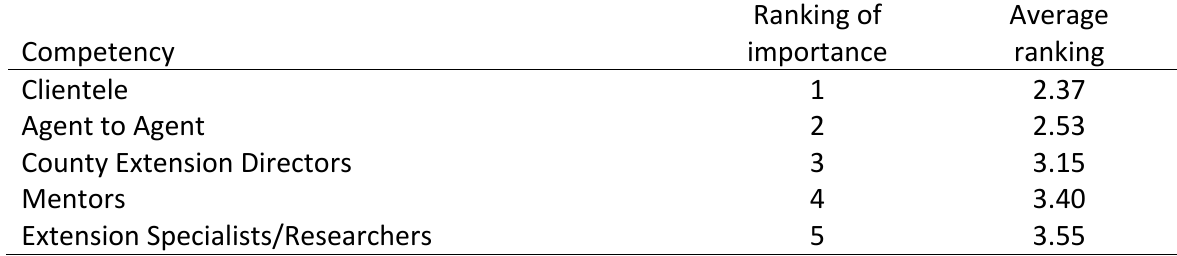
Ranking of Important Contacts from the Agent Relationships